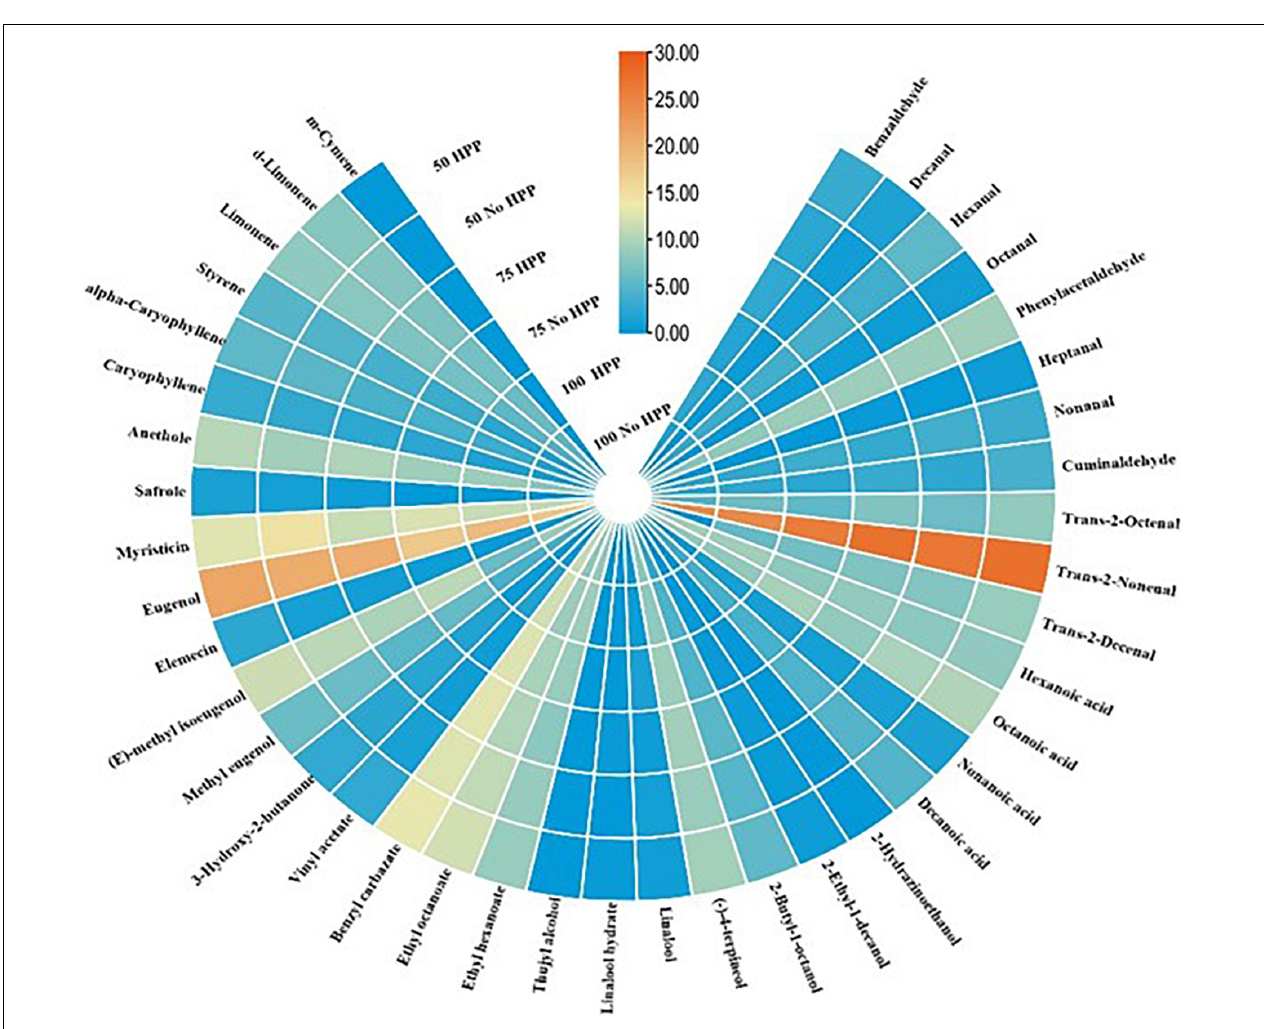
FIGURE 4 | Heat map of odor activity values (OAVs) of volatile compounds in sausage stored at 0 day. The color scale indicates the intensity of the OAV.